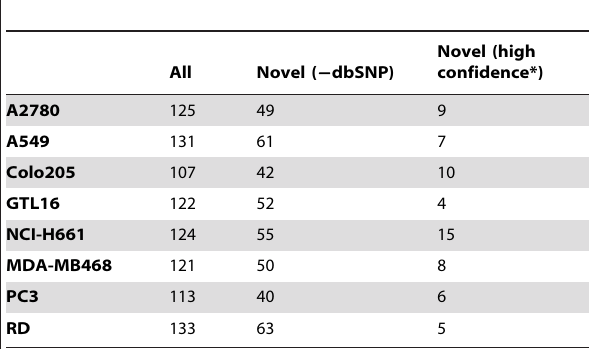
Table 4. Number of protein kinase genes with non- synonymous variants in each